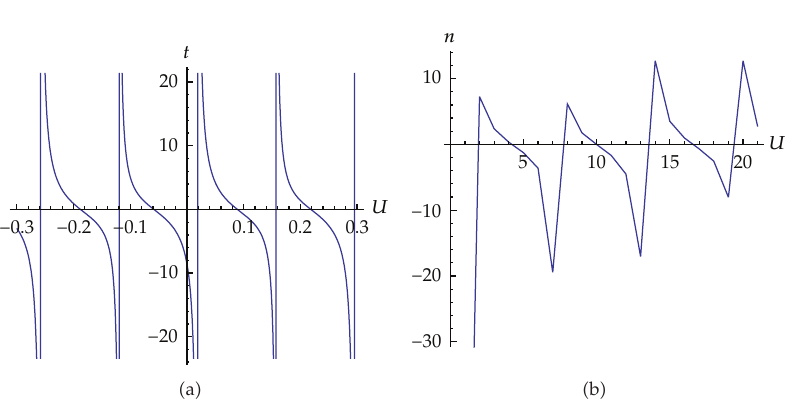
Figure 1: (cid:5) a (cid:6) represents the Jacobi elliptic solution (cid:5) 3.7 (cid:6) when β (cid:9) m (cid:9) 0 . 5, γ (cid:9) 1, α 1 (cid:9) 1 . 5, d (cid:9) 0 . 3, n (cid:9) 2. (cid:5) b (cid:6) represents the Jacobi elliptic solution (cid:5) 3.7 (cid:6) when β (cid:9) m (cid:9) 0 . 5, γ (cid:9) 1, α